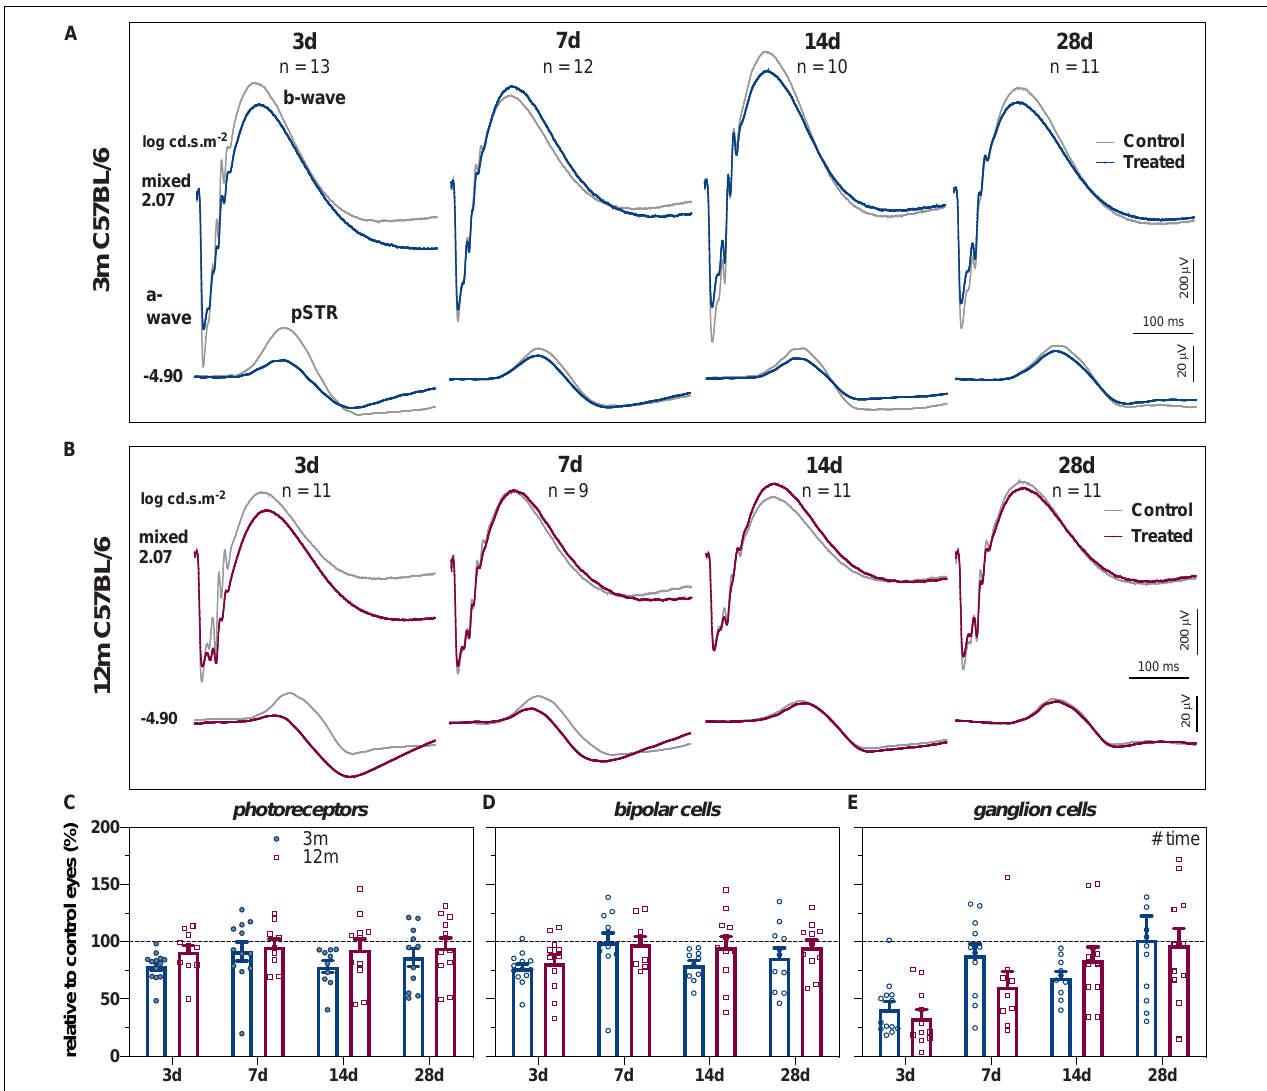
FIGURE 1 | Recovery of retinal function in 3- and 12-month-old C57BL/6 mice. (A) Group averaged ERG waveforms in 3-month-old mice (blue traces, treated eyes; gray traces, control eyes) at luminous energies representing predominantly ganglion cell responses (–4.90 log cd.s.m − 2 ) and outer retinal function (2.07 log cd.s.m − 2 ) at 3 ( n = 13), 7 ( n = 12), 14 ( n = 10), and 28 days ( n = 11). (B) Group averaged ERG waveforms in 12-month-old mice (red traces, treated eyes; gray traces, control eyes) at 3 ( n = 11), 7 ( n = 9), 14 ( n = 11), and 28 days ( n = 11). (C–E) ERG responses from IOP-treated eyes expressed relative to their contralateral control eyes for (C) photoreceptor amplitude, (D) bipolar cell amplitude, and (E) ganglion cell amplitude (pSTR) in 3-month-old (blue bars) and 12-month-old (red bars) mice. Error bars, SEM; #, two-way ANOVA p <